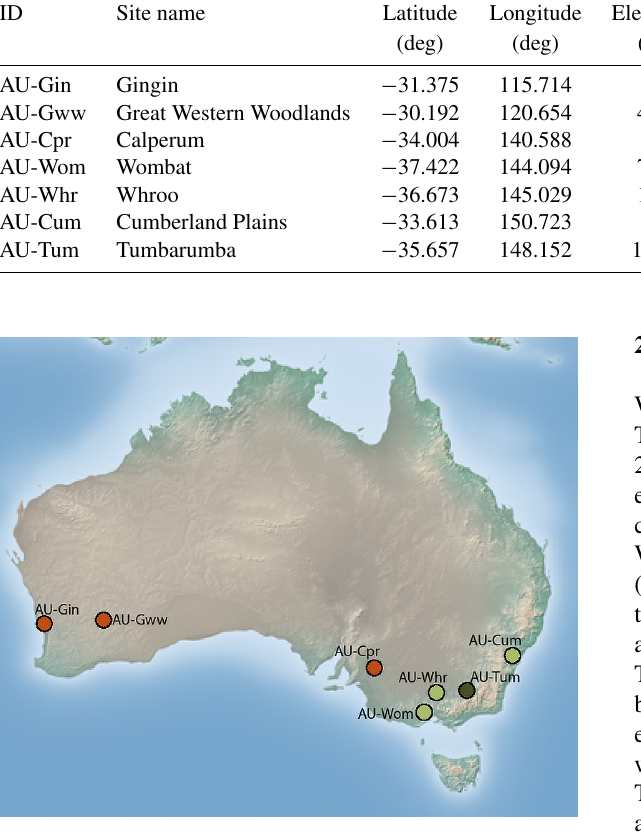
Figure 1. Map indicating the locations of the OzFlux sites used in this study. The sites are grouped into three distinct climate and ecosystem types, indicated by red dots for Mediterranean wood- lands (MW), light green dots for temperate woodlands (TW) and a dark green dot for the temperate forest